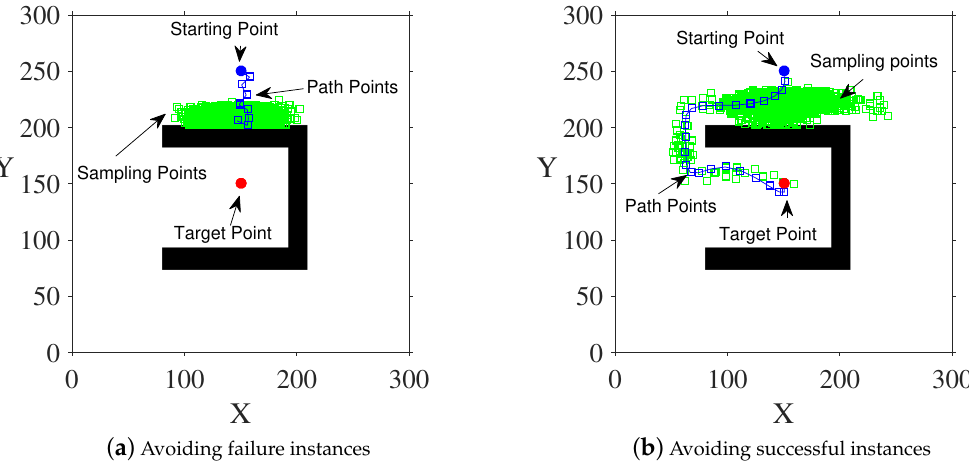
Figure 3. Avoid instances of local